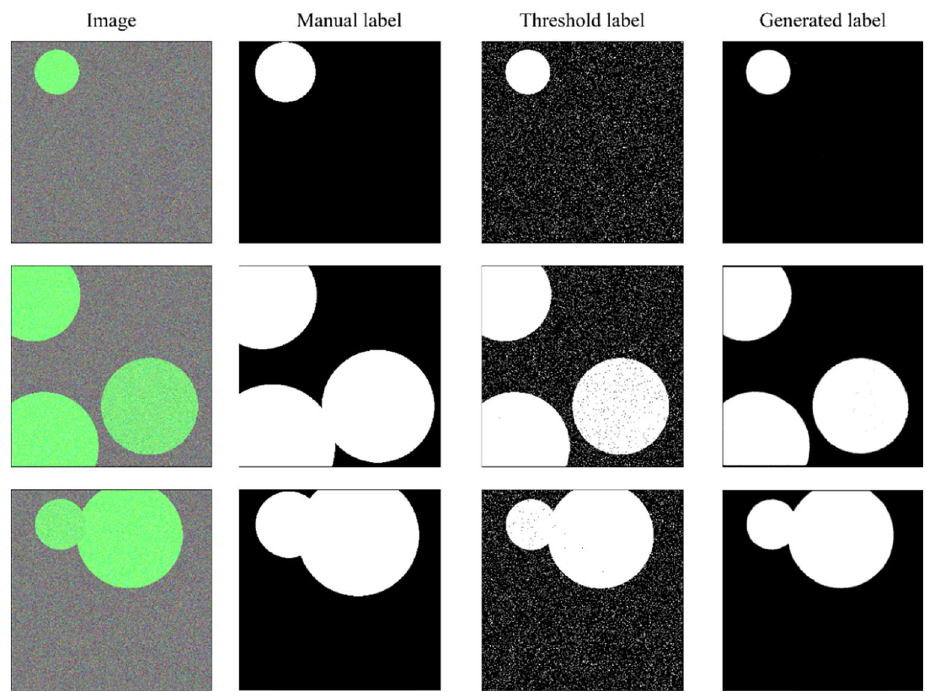
Figure 10. Training results on the Circle dataset. Annotations inside and outside the object were corrected through the interaction of MGRL and